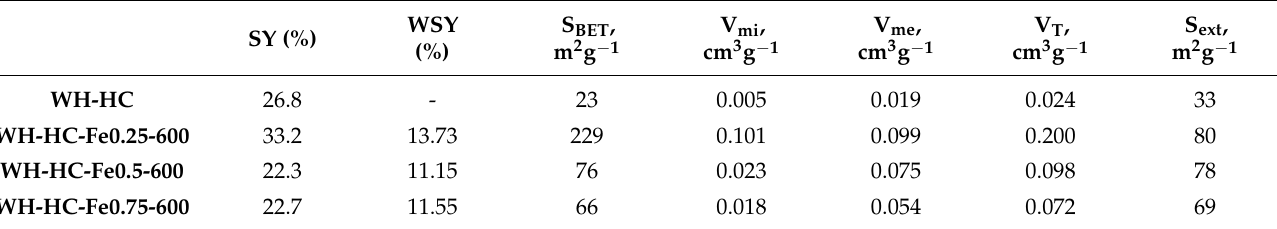
Table 2. Solid yield (SY, %) and N 2 adsorption textural parameters of Fe-catalyzed HTC. SY